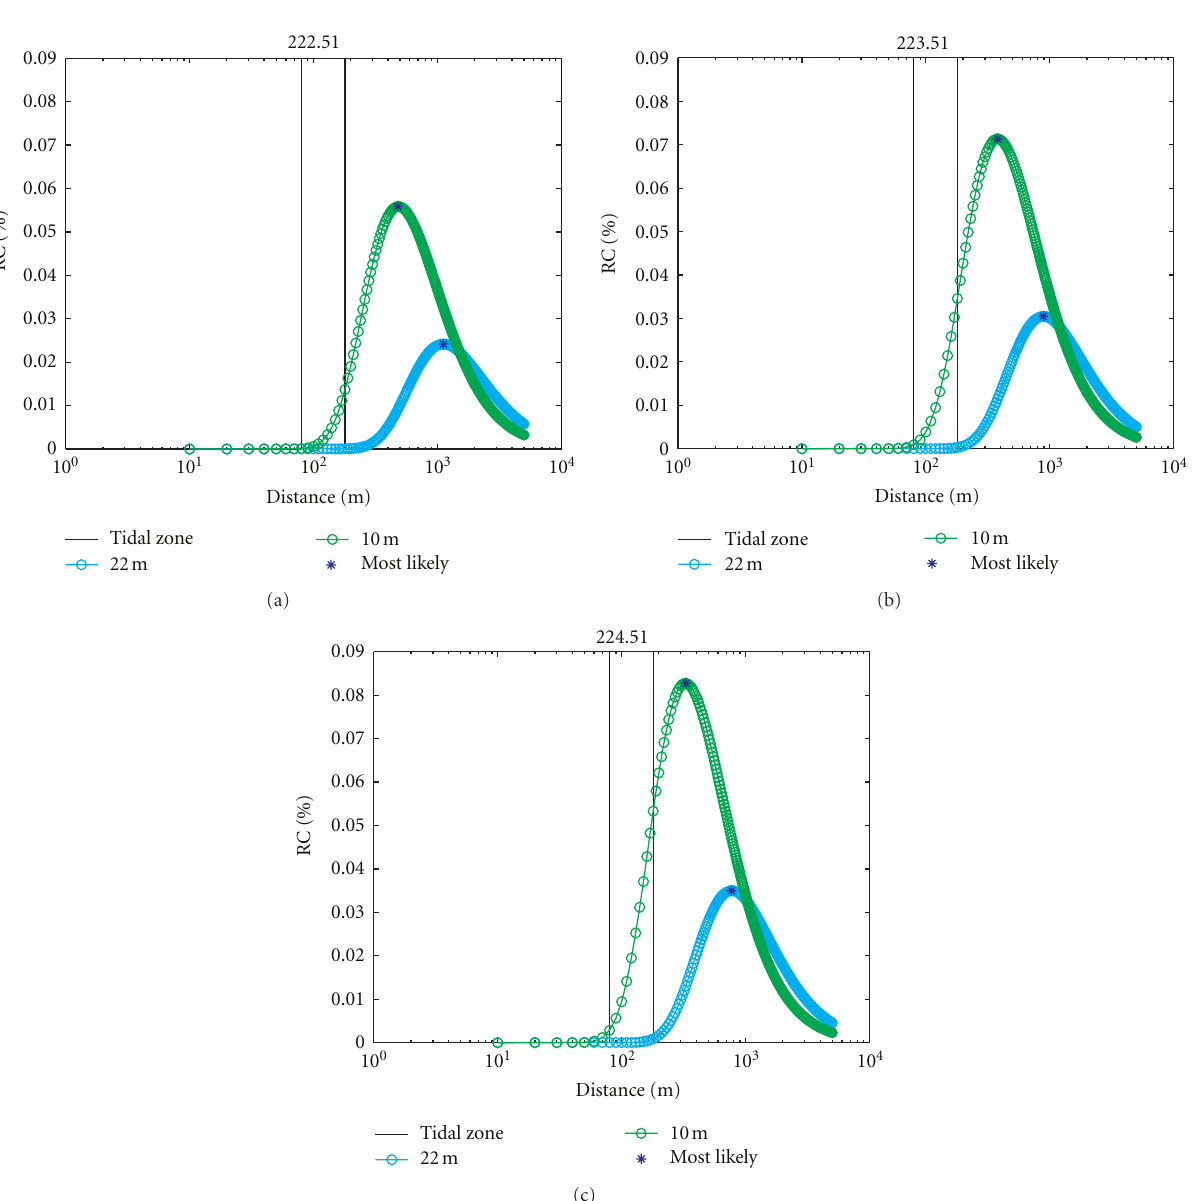
Figure 1: Relative contribution to flux footprint calculated at midday for relative measurement